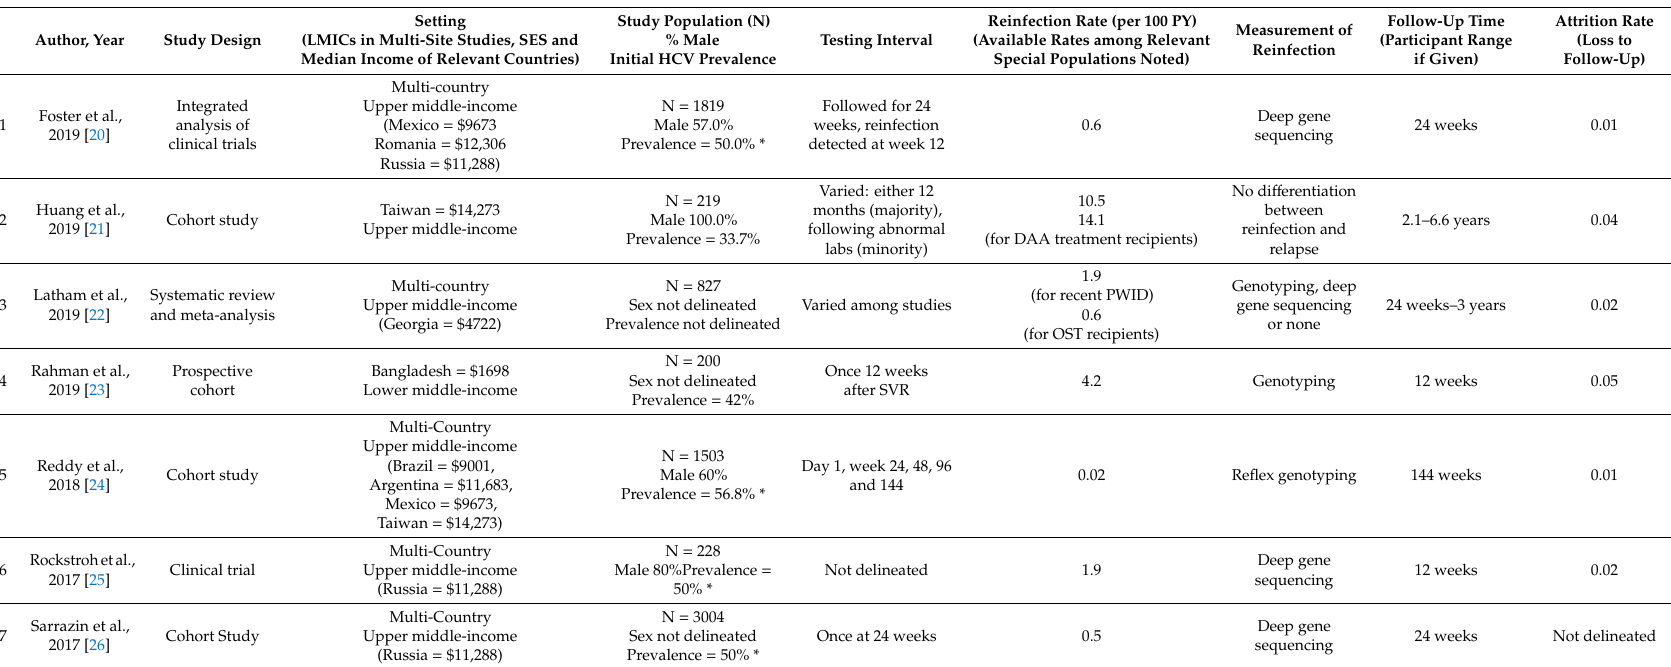
Table 1. Summary of studies on HCV reinfection in low- and middle-income